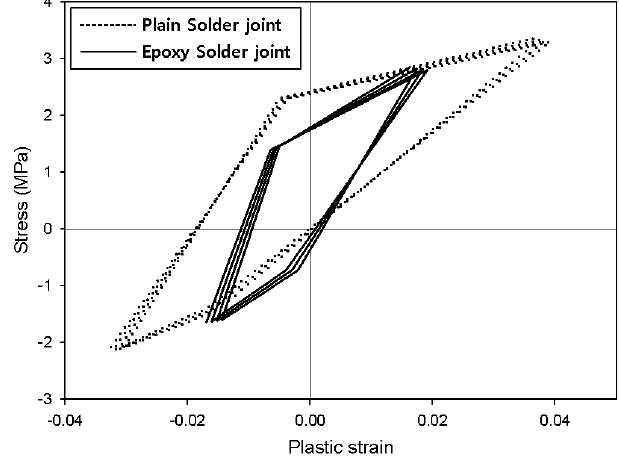
Figure 6. Plastic strain-stress curves for SAC305 solder joints.